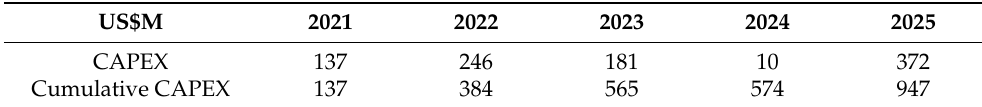
Table 7. CAPEX values of the company Li-Cycle. Source: